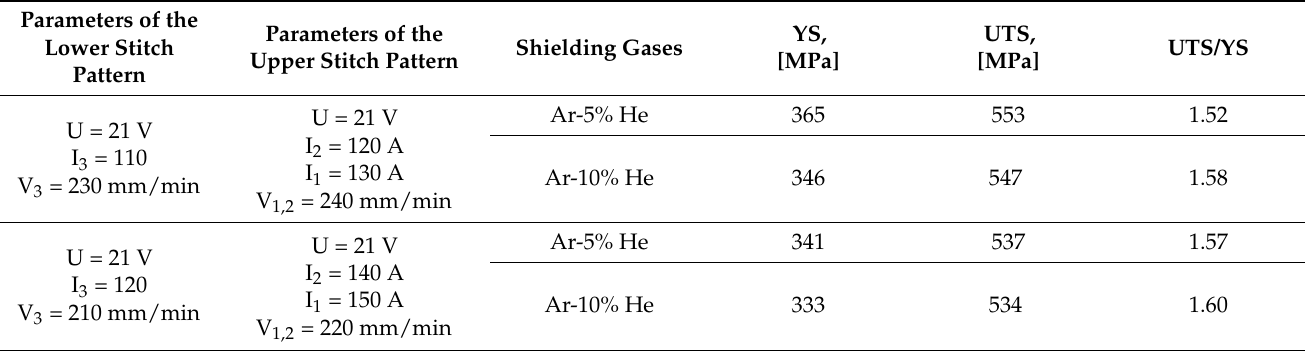
Table 2. Mechanical properties of the tested joints manufactured using the NiCr23Mo16 wire, YS- yield stress, UTS—ultimate tensile strength.